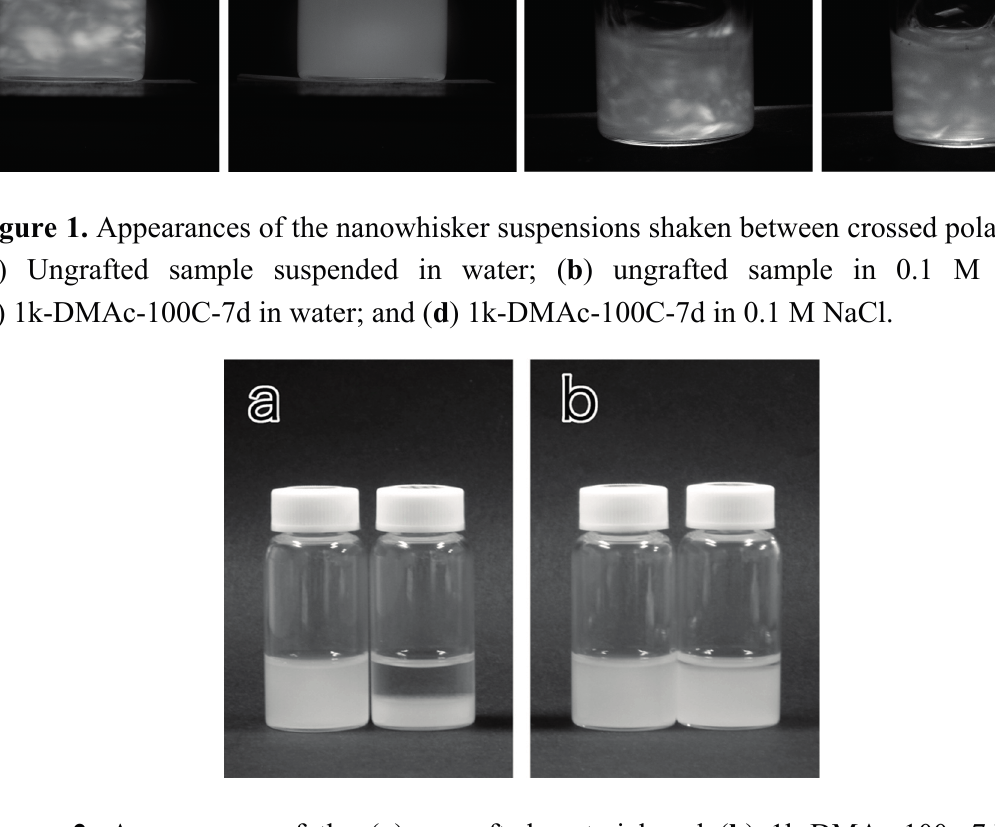
Figure 2. Appearances of the ( a ) ungrafted material and ( b ) 1k-DMAc-100c-7d after standing for 1 h. In both photographs, the NaCl concentrations in the left and right vials were 0 and 0.1 M, respectively. Nanowhisker content of the all samples was 0.1 wt